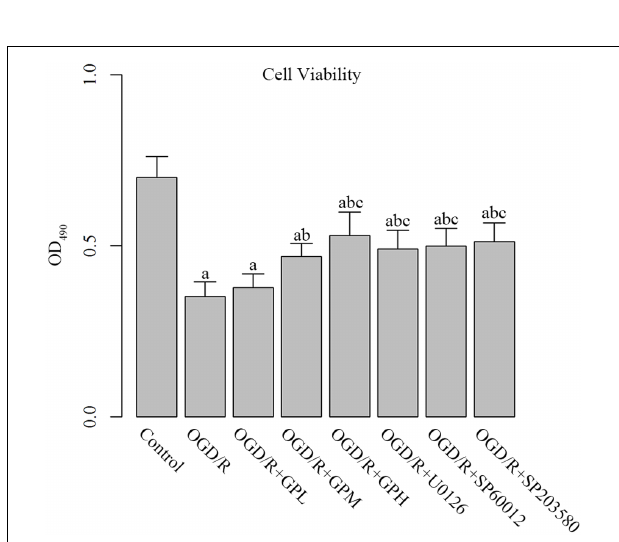
FIGURE 2 | Administration enhanced cell viability in OGD/R injured H9c2 cells. a, significantly different from Control group, P < 0.05. b, significantly different from OGD/R group, P < 0.05. c, significantly different from sham group OGD/R + GPL group, P < 0.05.